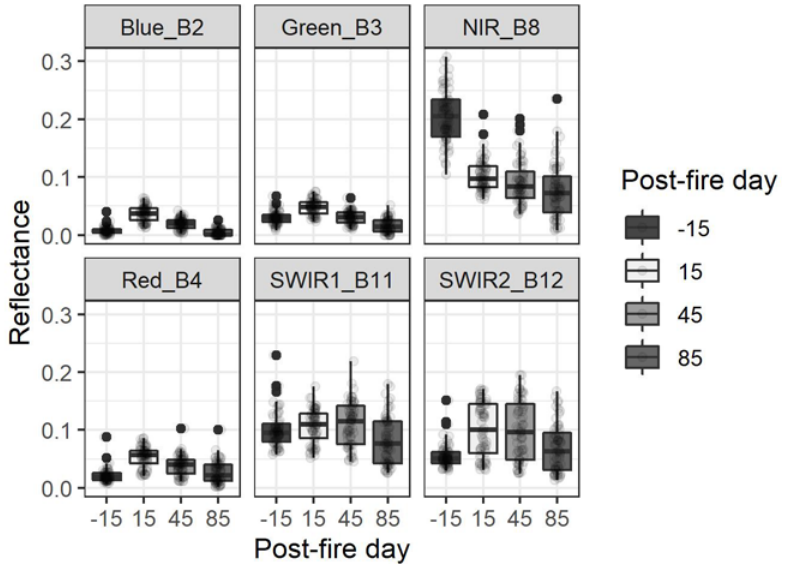
Figure 6. Box and whisker plots illustrating the change in Sentinel-2 band reflectance over time from the Mesa Fire data.